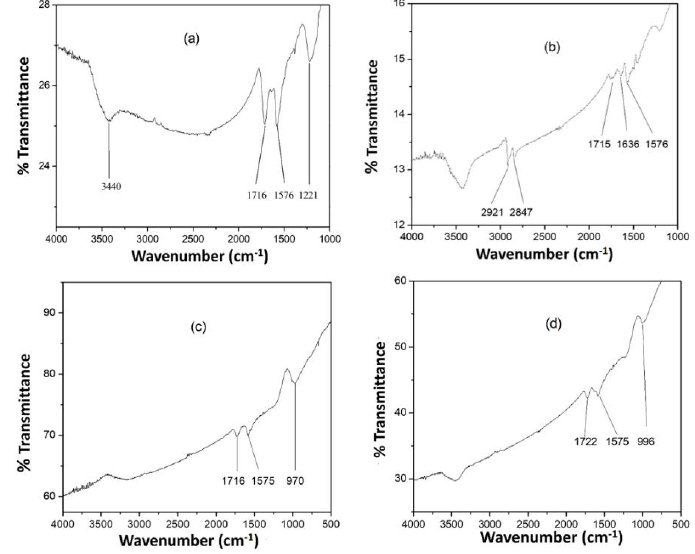
Figure 2. FTIR data for ( a ) MWCNT-COOH, ( b ) MWCNT-ODA, ( c ) p-MWCNT-Pd, and ( d ) np-MWCNT-Pd.